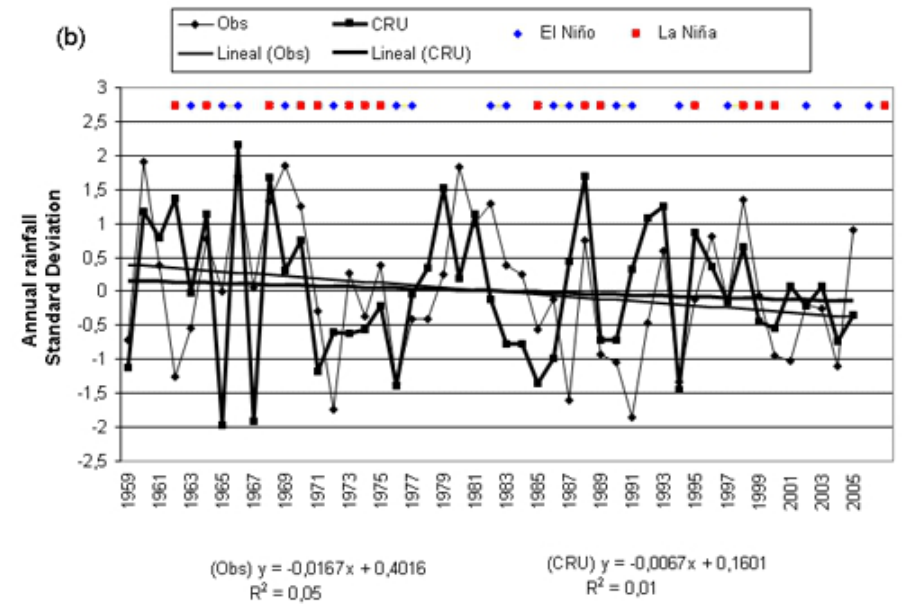
Fig. A.1.1 b . Trends in annual total rainfall from 1959 to 2005 (the data have been standardized to facilitate